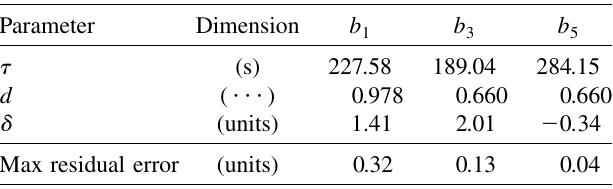
FIG. 3. (Color) The b decay model of one aperture on an 3 injection plateau of 10000 s. The residual error between the model and the data is below 0.1 units over the whole range. TABLE II. Parameters obtained fitting the model of Eqs. (3)– (7) to the average decay in the population analyzed, representing the behavior of the